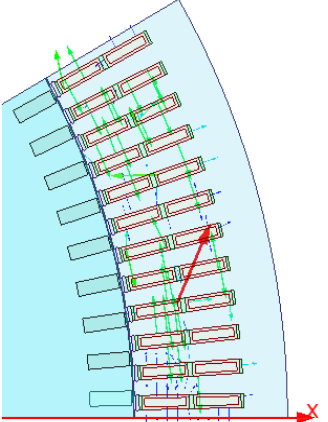
Figure 3. Zoomed-in contour of leakage current density vectors (A/m 2